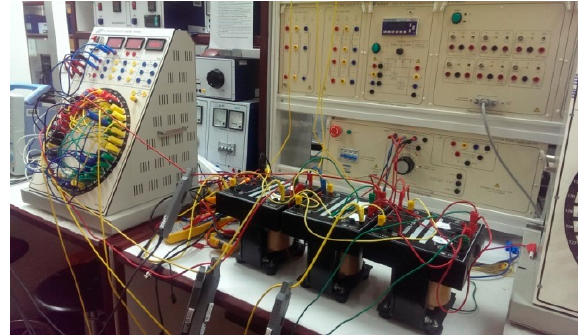
Figure 14. Experimental set-up.